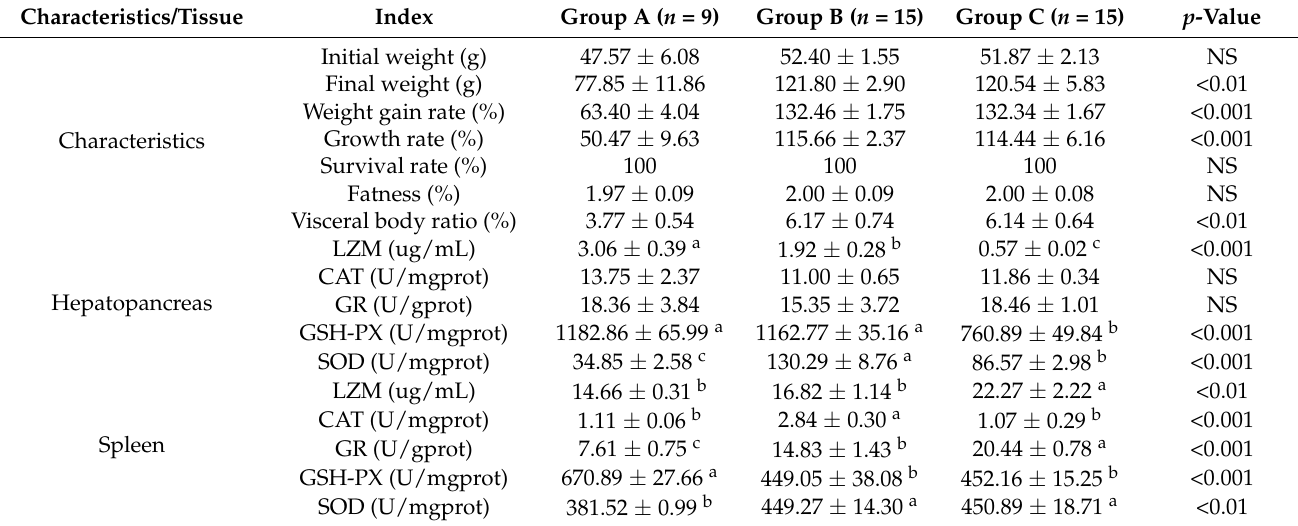
Table 1. Characteristics and non-specific immunity related enzyme index of bighead carp.